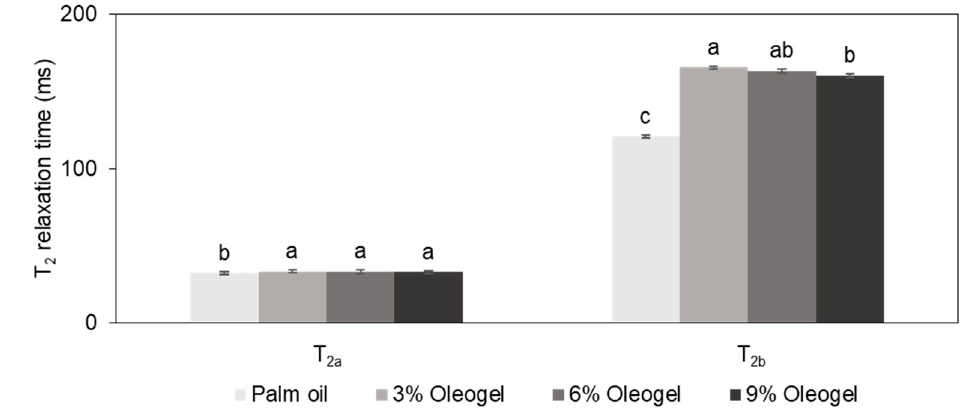
Figure 3. Effect of palm oil replacement with oleogels on the spin–spin relaxation (T2) times of imitation cheeses (means with different letters in the same classification significantly differ at p < 0.05).